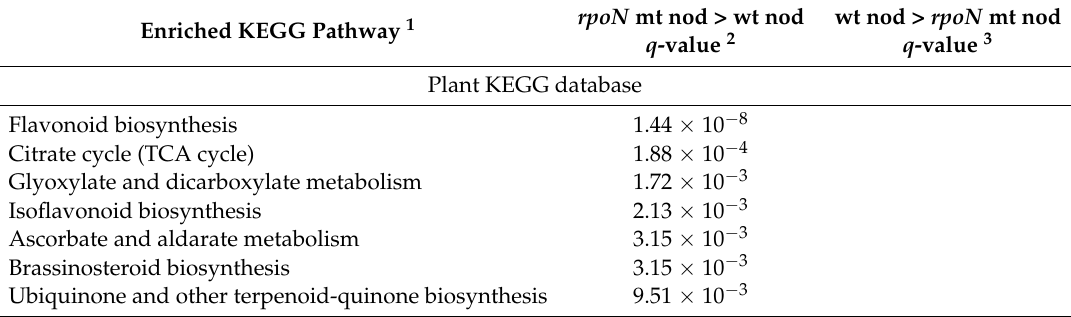
Table 1. Enriched pathways for metabolites differentially accumulating in nodules induced by the rpoN mutant ( rpoN mt nod), versus nodules occupied by the wild type (wt nod) and vice versa. The enrichment analysis was performed using plant and bacterial metabolites